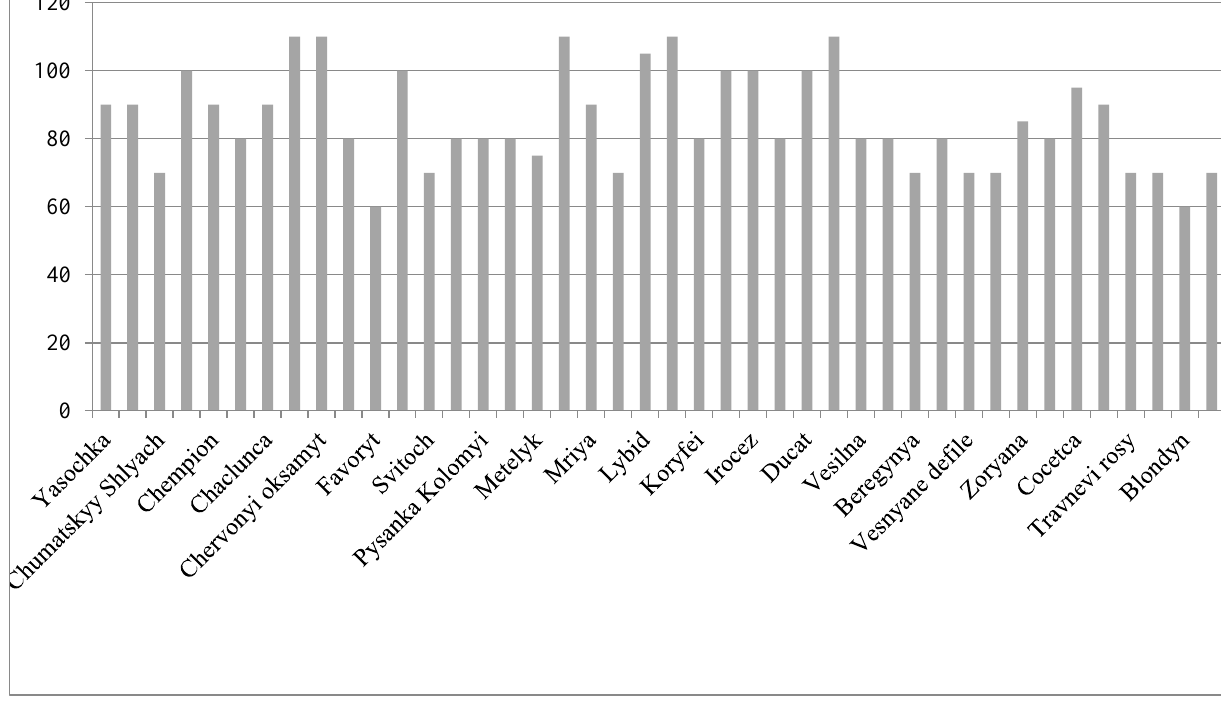
Fig. 2. Height of plants of the peonies, entered into the state registry of Ukraine, cm Growth processes in plants are always accompanied by an increase in their size and mass and diameter of the flower (Figure